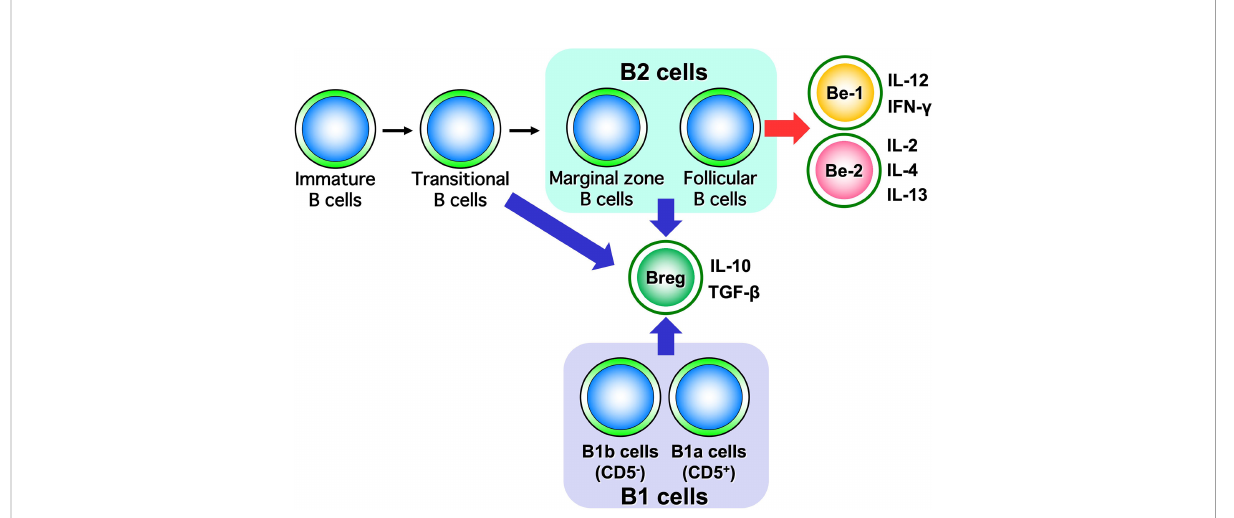
FIGURE 6 Classi fi cation of B cells by cytokine-producing capacity. B cells are classi fi ed into Be cells and Breg cells based on the type of cytokines they produce. It has been suggested that Be cells are part of B2 cells, while Breg cells are part of both B1 and B2